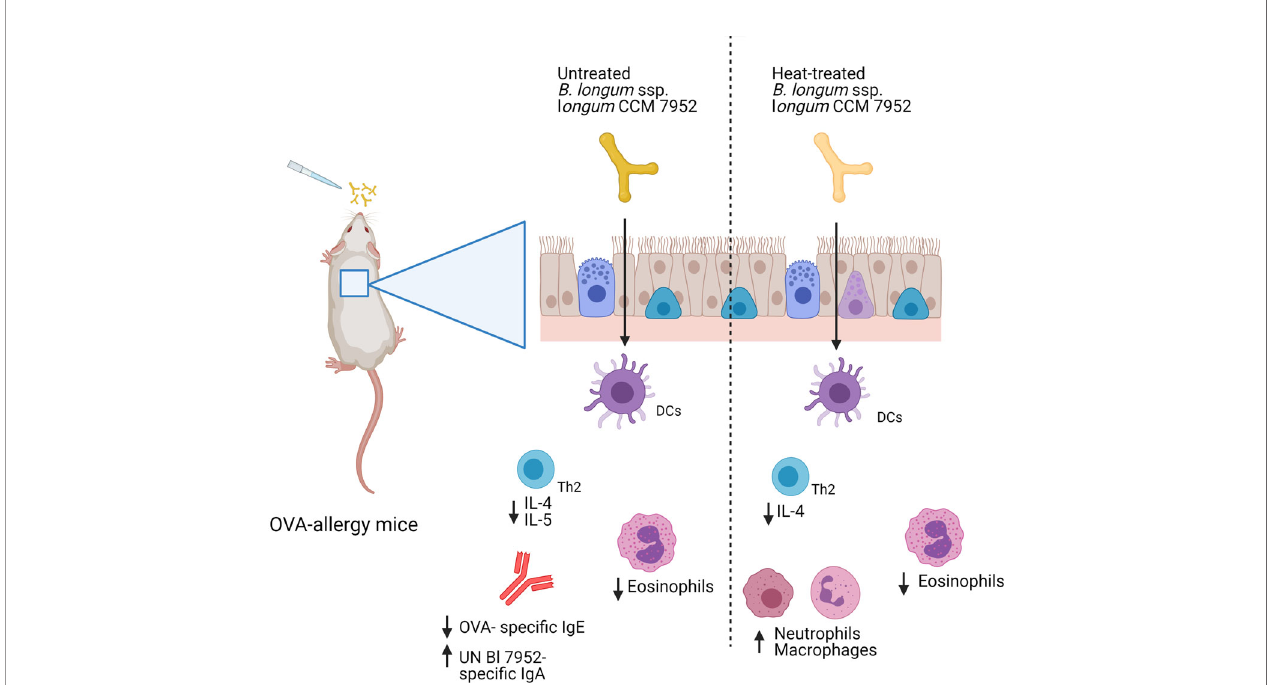
FIGURE 7 | Graphical representation of results. Intranasal administration of Bl 7952 to OVA-sensitized mice suppresses allergic in fl ammation. However, thermal inactivation of Bl 7952 modi fi es the immunomodulatory properties of this strain (Created with